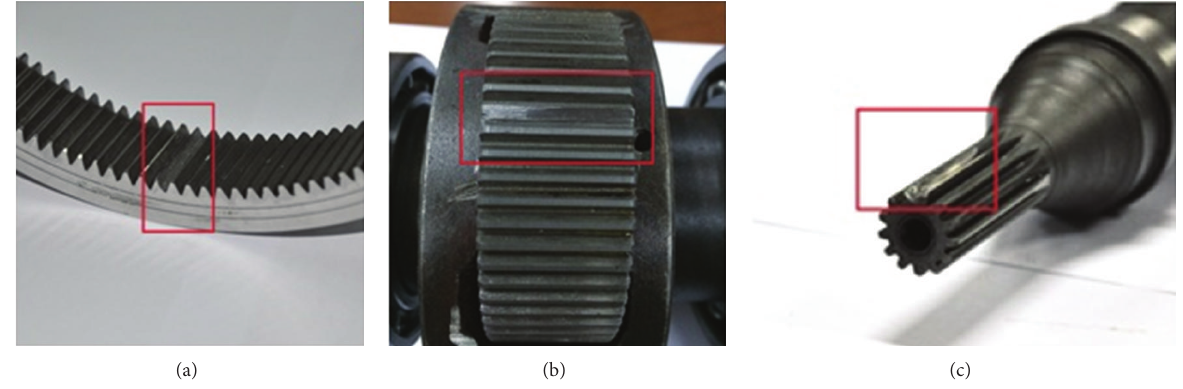
Figure 24: Implanted wear fault: (a) ring gear, (b) planet gear, and (c) sun